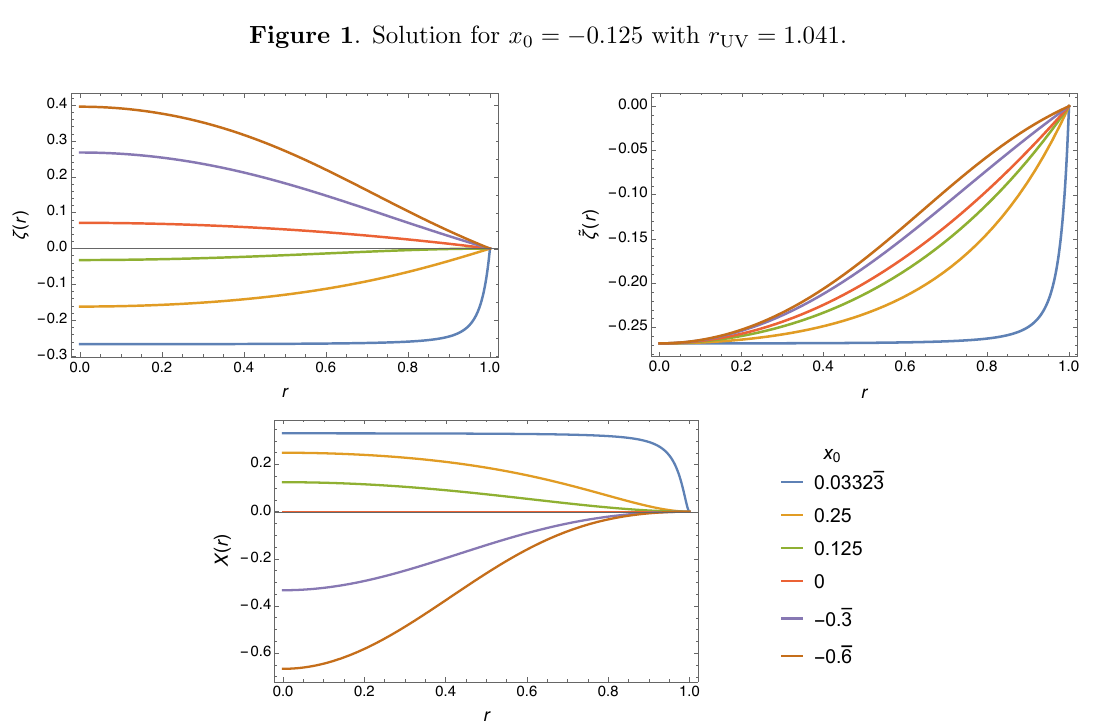
Figure 2 . A family of solutions of (4.38) for di(cid:11)erent values of x 0